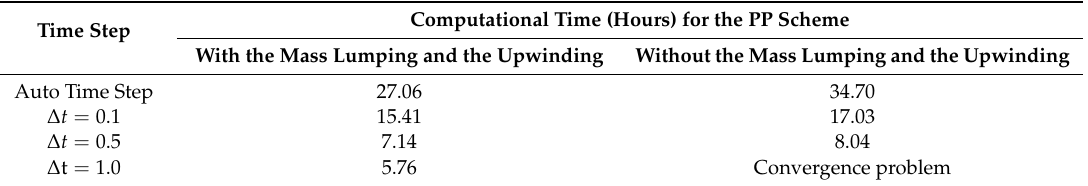
Table 5. Computational time with and without the mass lumping and the